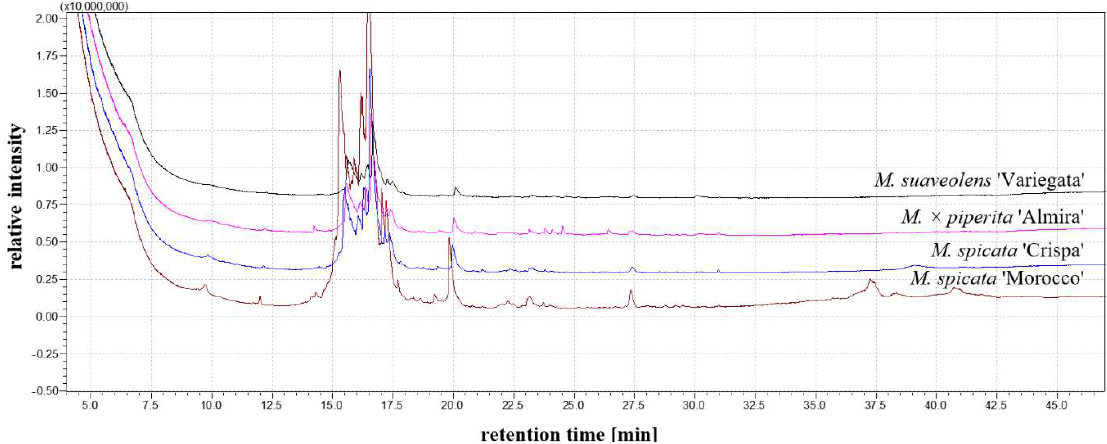
Figure 13. Mentha spp chromatogram. Table 3. Chemical composition of the water mint extracts. Concentration (%) Calculated Relative to the Area of